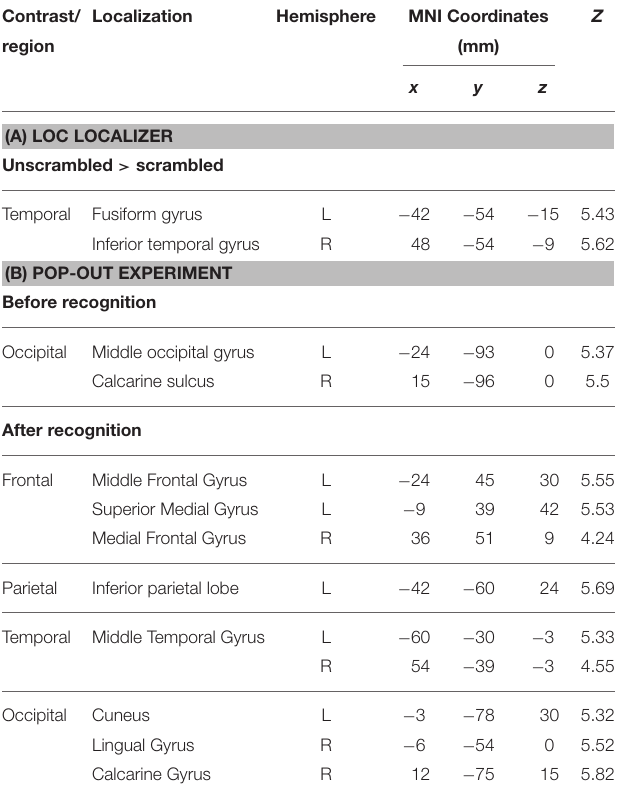
TABLE 3 | (A) LOC localizer to guide the identification of LO by contrasting unscrambled with scrambled objects, (B) regions of cerebral activations before (Image > Recognition) and after the moment of recognition (Recognition >